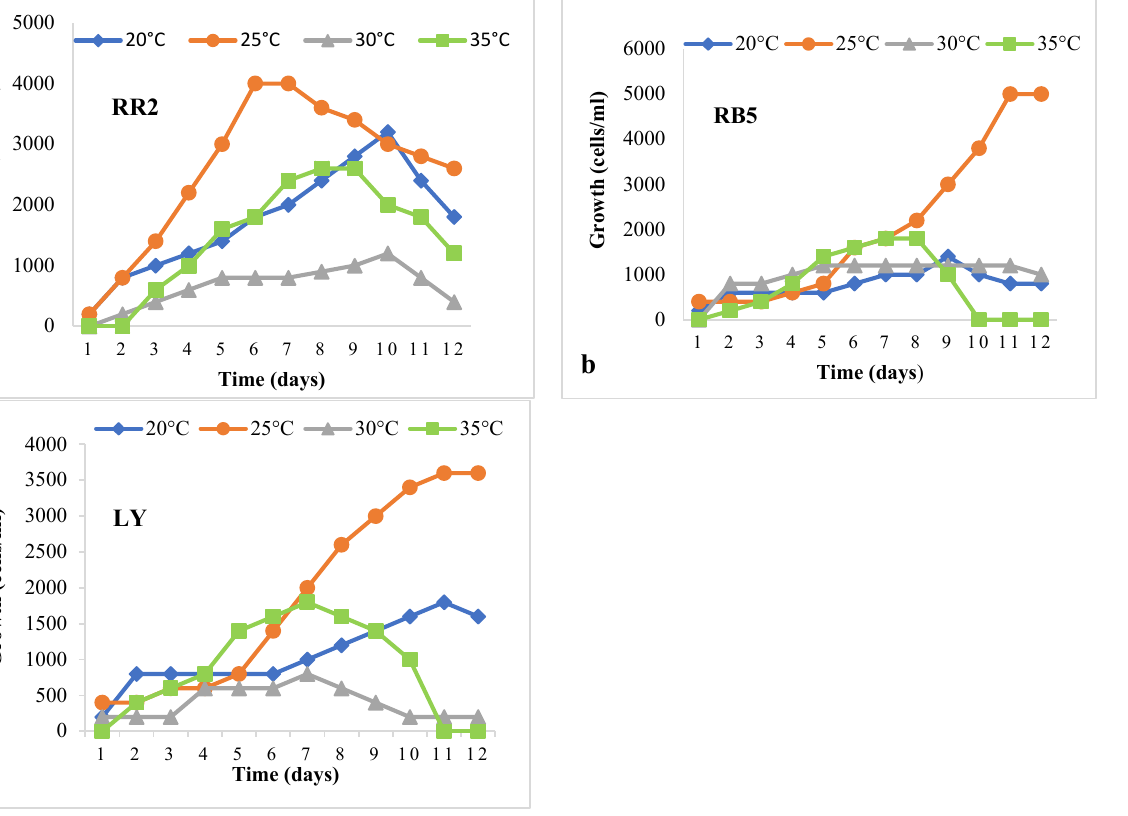
Figure 5. Growth curves of P. caudatum UR03 in culture medium containing azo dyes, RR2 ( a ), RB5 ( b ) and LY ( c ) at different temperatures.